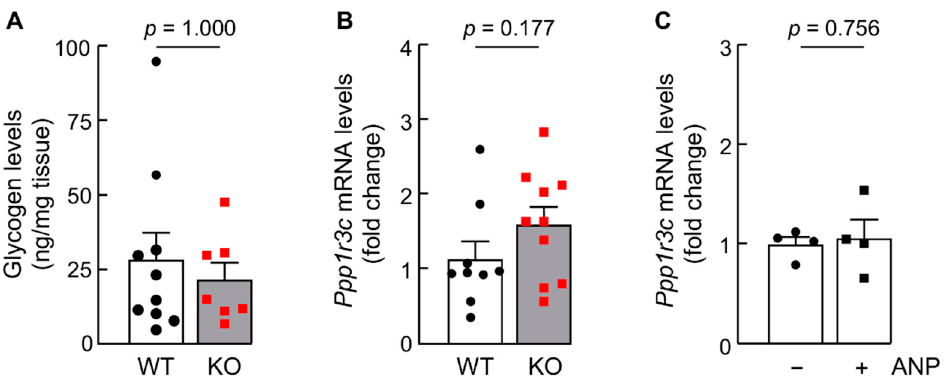
Figure 8. Glycogen and Ppp1r3c mRNA levels in iBAT from WT and corin KO mice. ( A , B ) Glycogen ( A ) and Ppp1r3c mRNA levels ( B ) were analyzed in iBAT from WT and corin KO mice (4 - month-old males) ( n = 7–10). ( C ) Ppp1r3c mRNA levels in iBAT-derived adipocytes from WT mice without ( −